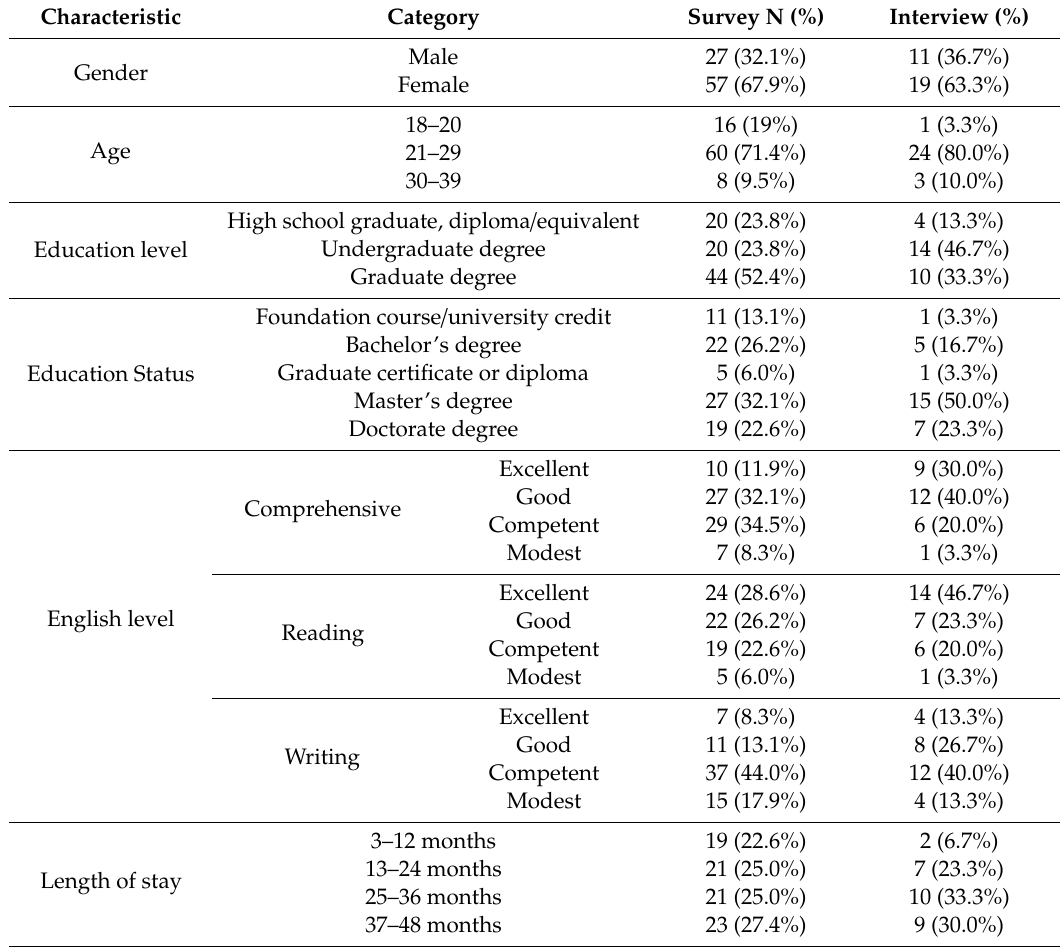
Table 1. Participants’ demographic characteristic